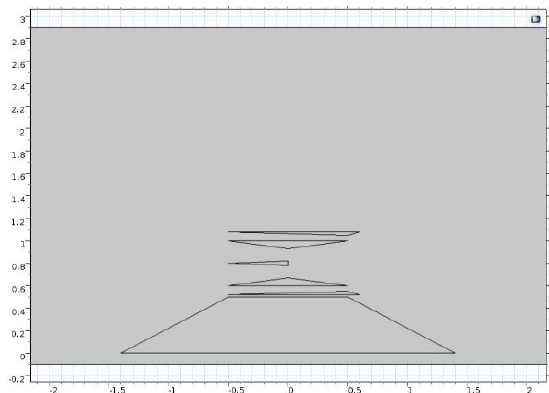
Figure 2. The cross-section of model of the closed type